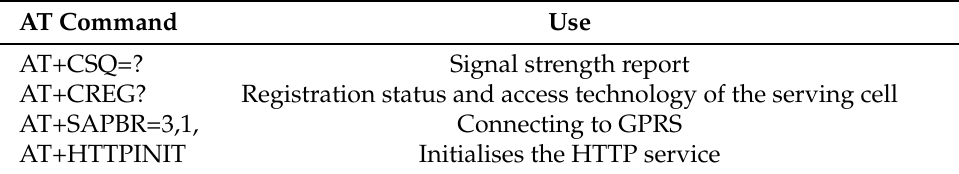
Table 1. Description of AT Commands used.